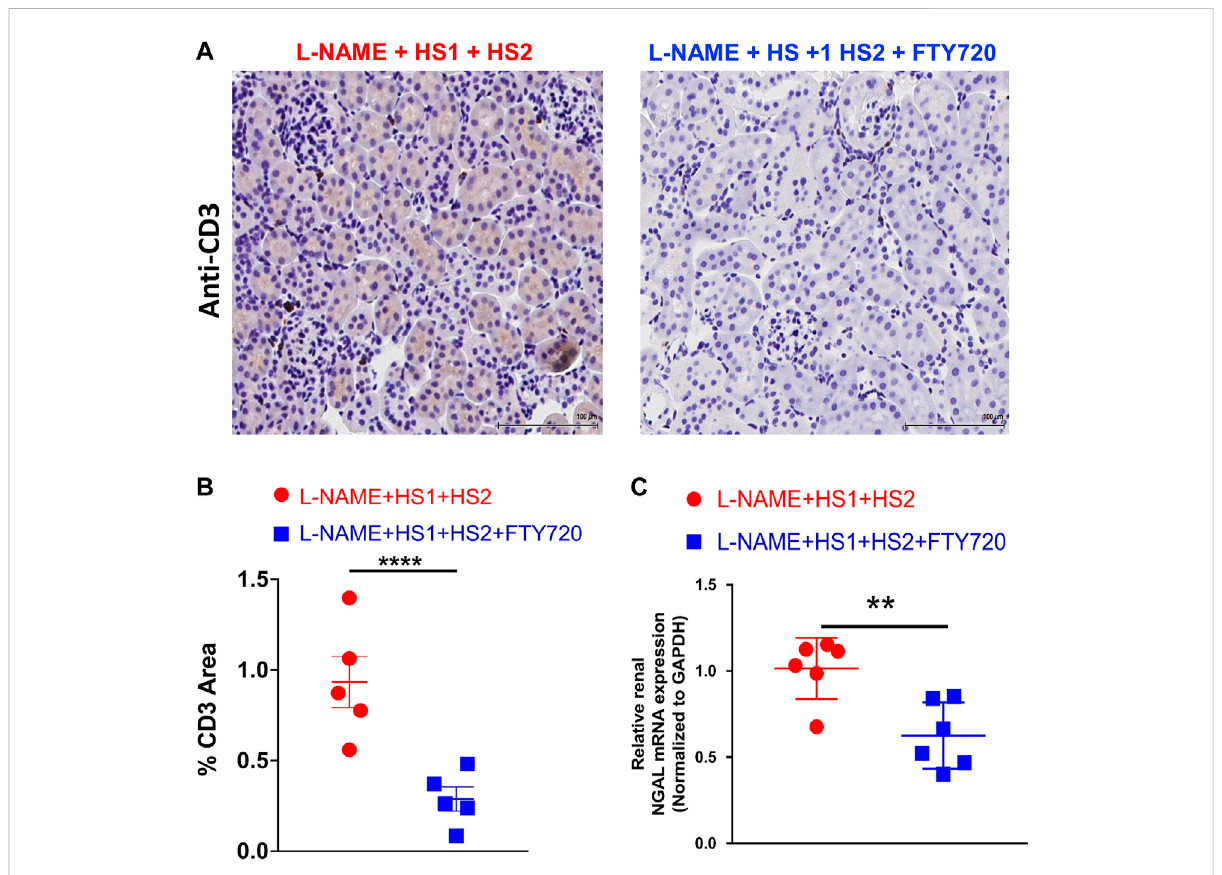
FIGURE 3 Fingolimod protects renal tissue from injury in mice following L-NAME + HS1+HS2± fi ngolimod protocol. (A) Immunohistochemical analysis of CD3 + T-cells expression in mice kidney tissue after receiving L-NAME + HS1+HS2± fi ngolimod. (B) Dot plot showing the percentage of CD3 + area in therenaltissueofthemicefollowingL-NAME+HS1+HS2± fi ngolimodprotocol.N=5mice/group. (C) FoldchangeofexpressionofNGALrelativeto GAPDH in the kidney of mice that received L-NAME + HS1+HS2± fi ngolimod. N = 6 mice/group. Data are expressed as mean ± SEM. p -values calculated by unpaired t -test were shown. ** p < 0.001, *** p <